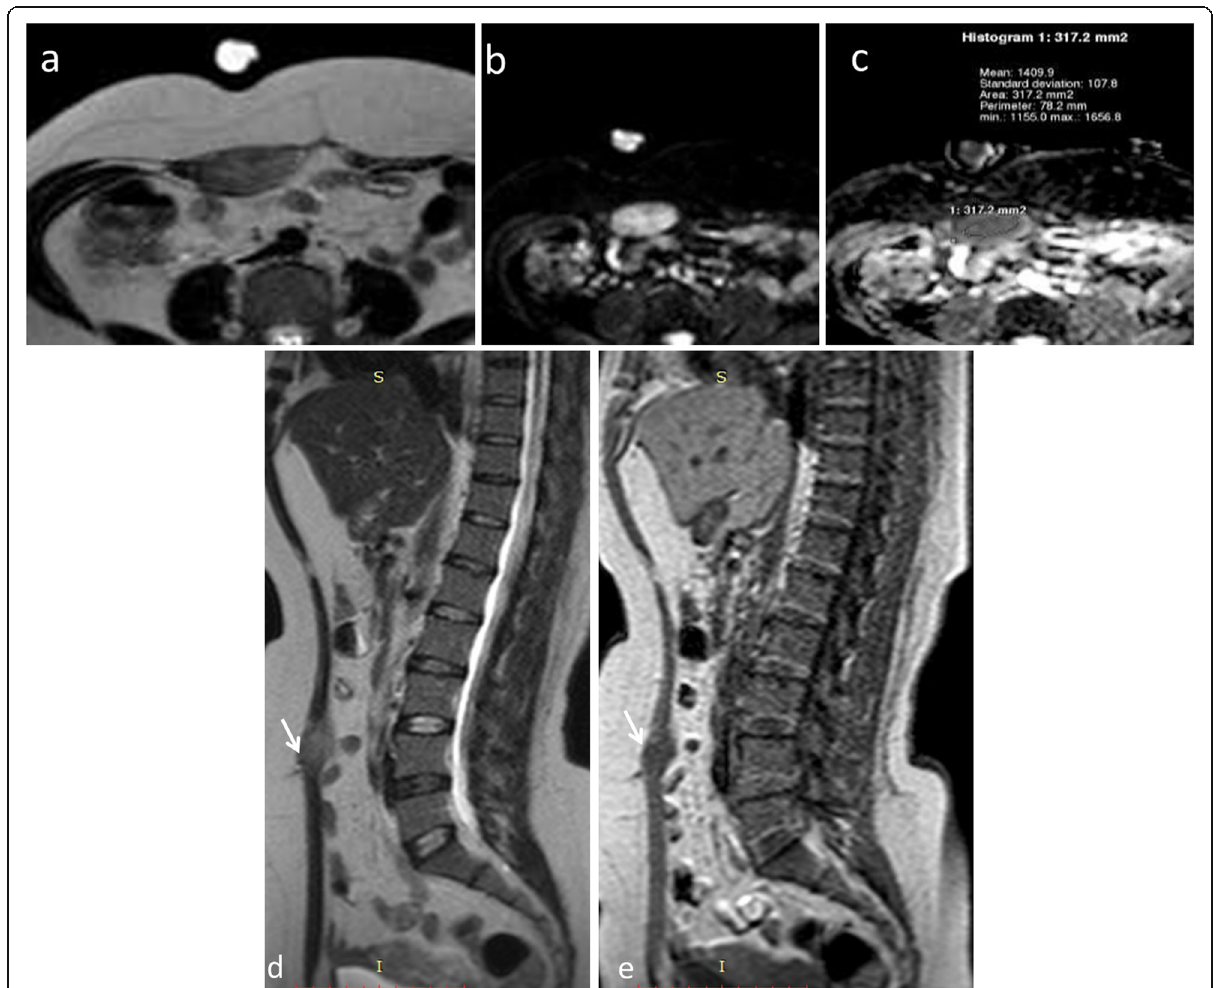
Fig. 4 Anterior abdominal wall fibromatosis presenting in a 41-year-old female a axial T2WI showing a well-defined right rectus abdominis intra- muscular lesion of hyper-intense signal relative to the normal muscles; b axial DWI and c the corresponding ADC images show that the lesion exhibits high signal on the DWI that turned to intermediate signal on the ADC map. Upon placing a ROI that covered the maximum diameter of the lesion, the mean and minimum ADC values were 1.4 × 10 − 3 and 1.1 × 10 − 3 mm 2 /s respectively. Sagittal T2 ( d ) and T1 ( e ) images; arrow pointing to the same